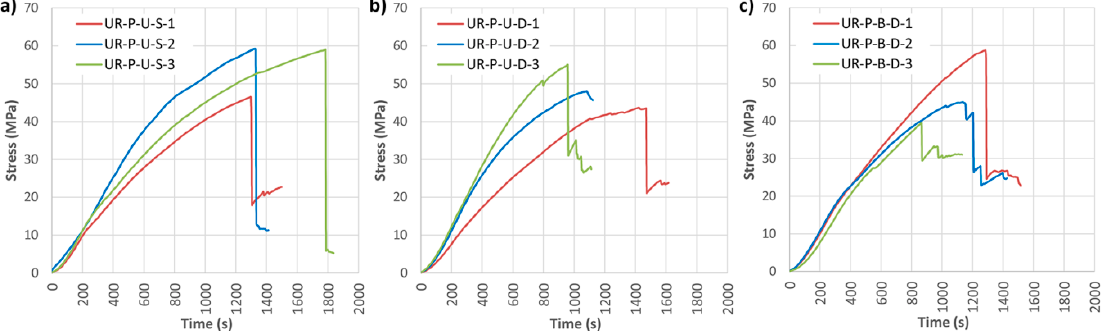
Figure 18. Maximum bending capacity (MOR) against time for U-shaped reinforced beams with CFRP lamella (UR-P): ( a ) UR-P-U-S; ( b ) UR-P-U-D; and ( c ) UR-P-B-D. CFRP suppliers: SIKA ® and DRIZORO ® .